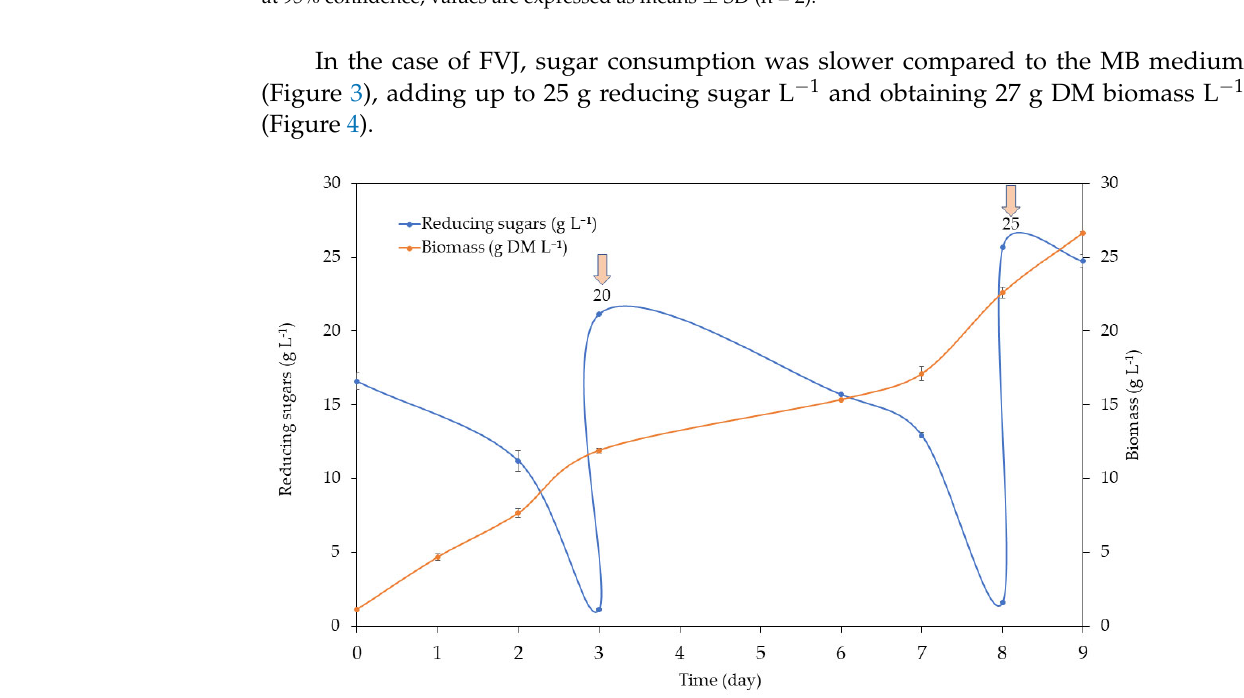
Figure 4. Reducing sugar consumption expressed as g L − 1 of glucose in the reactor (before and after adding fresh medium), and biomass production (g DM L − 1 ) through the experimental days using fruit and vegetable juices (FVJ) medium.